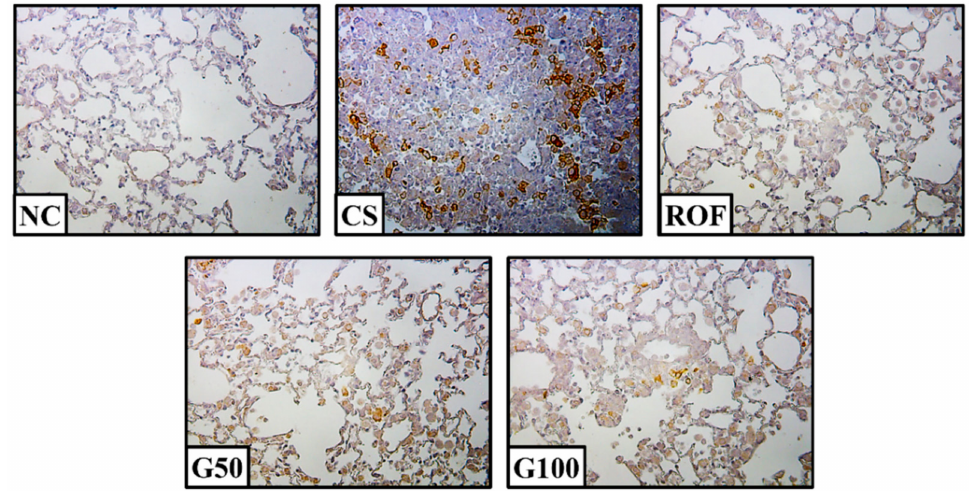
Figure 6. GGWE attenuate the activity of iNOS in lung tissue. NC, non-treated mice; CS, CS and LPS exposure mice; ROF, roflumilast 10 mg/kg and CS and LPS exposure mice; G50, GGWE 50 mg/kg and CS and LPS exposure mice; G100, GGWE 100 mg/kg and CS and LPS exposure